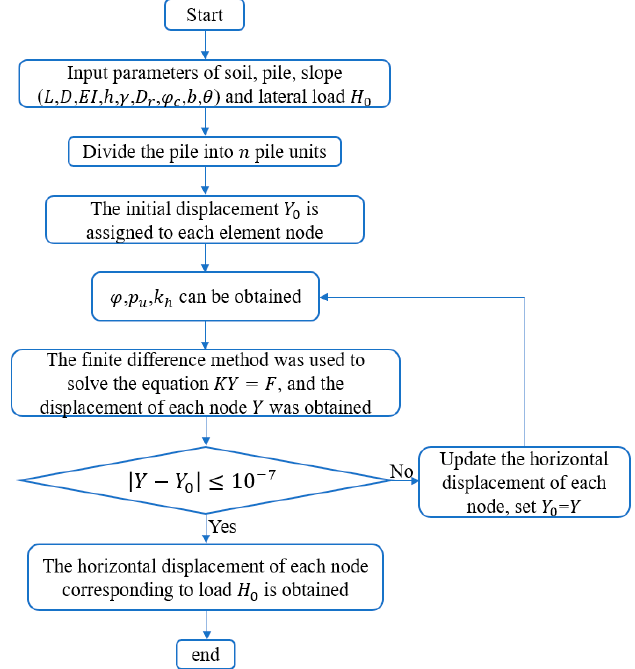
Figure 7. The solution fl ow chart of the proposed method.